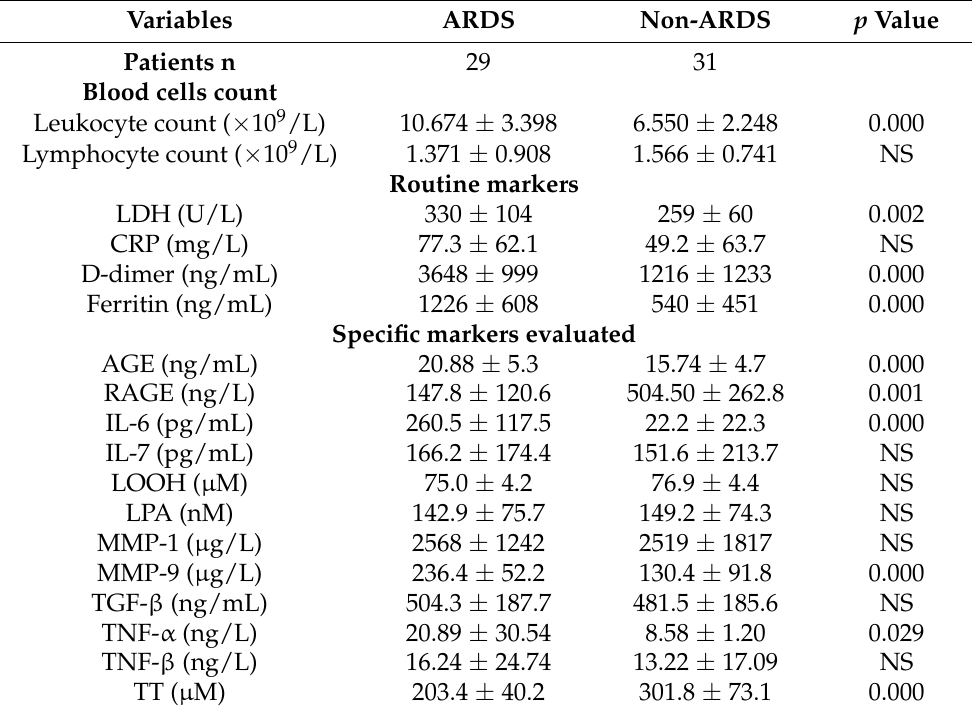
Table 3. Values of variables a week after hospital